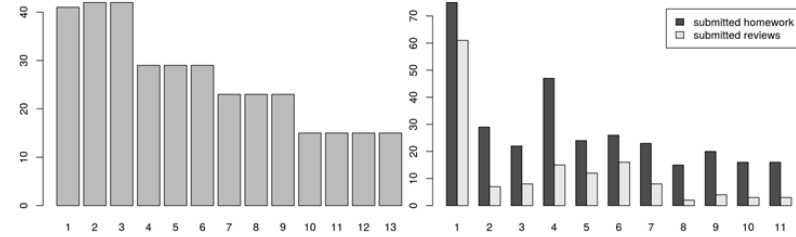
Fig. 2. Left: Numbers of students at each week, Right: Numbers of homework and peer re- views submissions at each